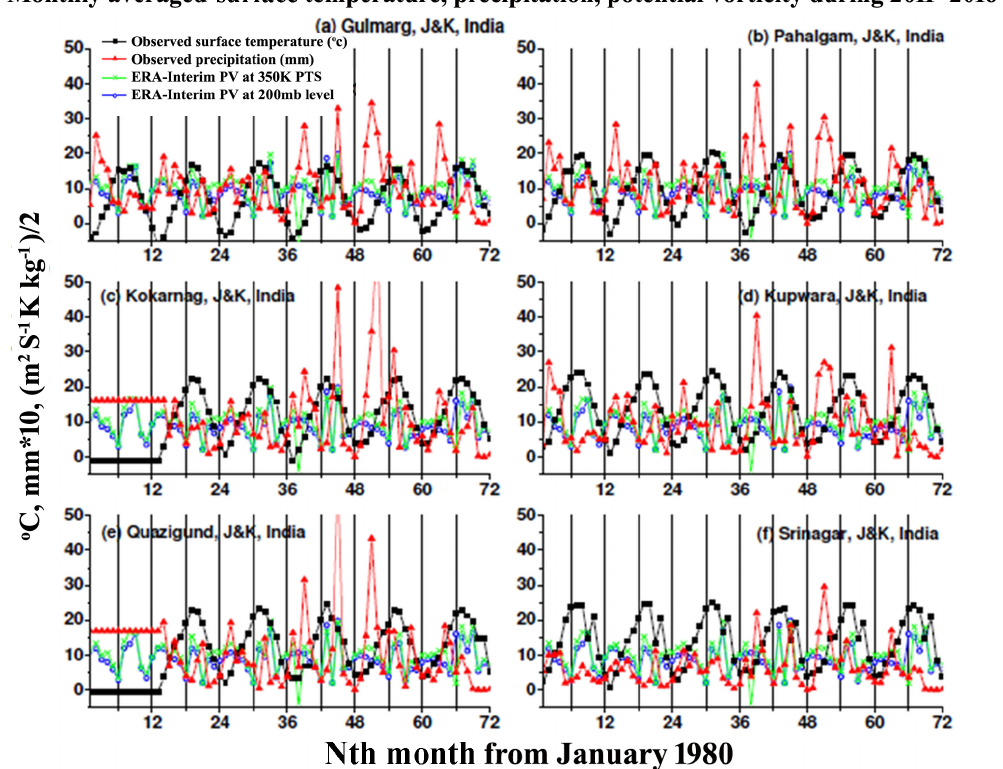
Figure 13. Same as Fig. 11 but for all the stations and during the years